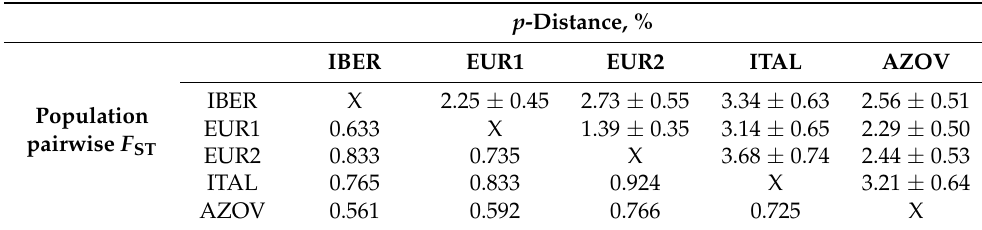
Table 1. Pairwise distances and F ST values between genetic groups of A. anatina ( p < 0.00001 for all F ST